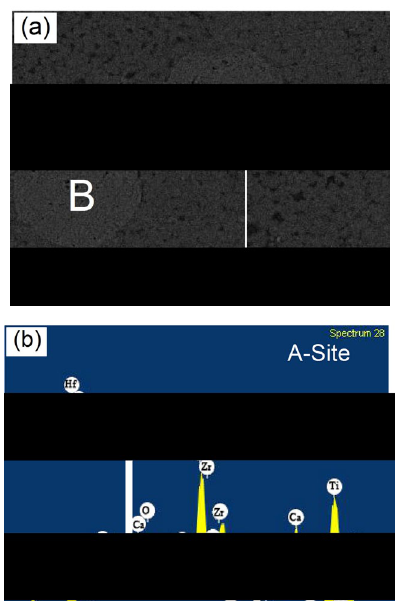
Fig. 7 EDX spotting results of Cu-Hf-0.6 sample: (a) representative BSE image, (b) elemental spotting analysis of the “A” region.